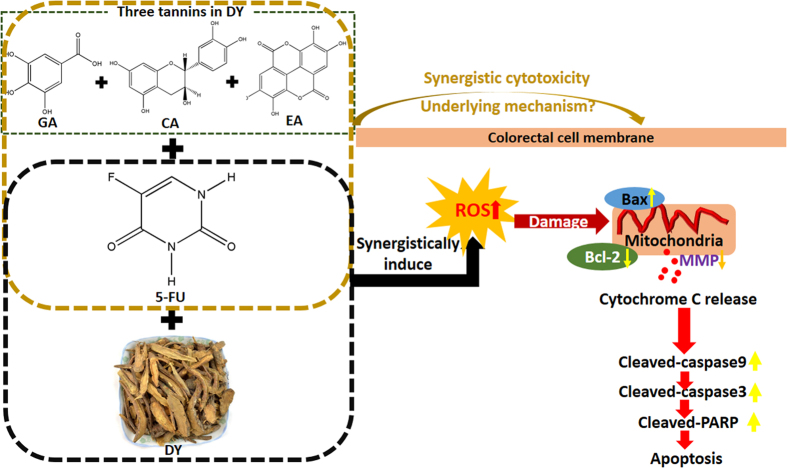
A schematic diagram of a ROS-mediated, mitochondria-caspase-dependent apoptosis involved in mediating the synergistic anti-proliferative effects of DY/tannins and 5-FU against CRC.DY and 5-FU synergistically promoted the generation of ROS in CRC cells and triggered a mitochondria disruption (cytochrome c release) by boosting the ratio of Bax/Bcl-2, which then activated caspase-9/3 and PARP. A combination of GA, CA and EA exhibited comparable synergistic effects on 5-FU cytotoxicity to DY water extract, but the underlying mechanism needs to be explored.